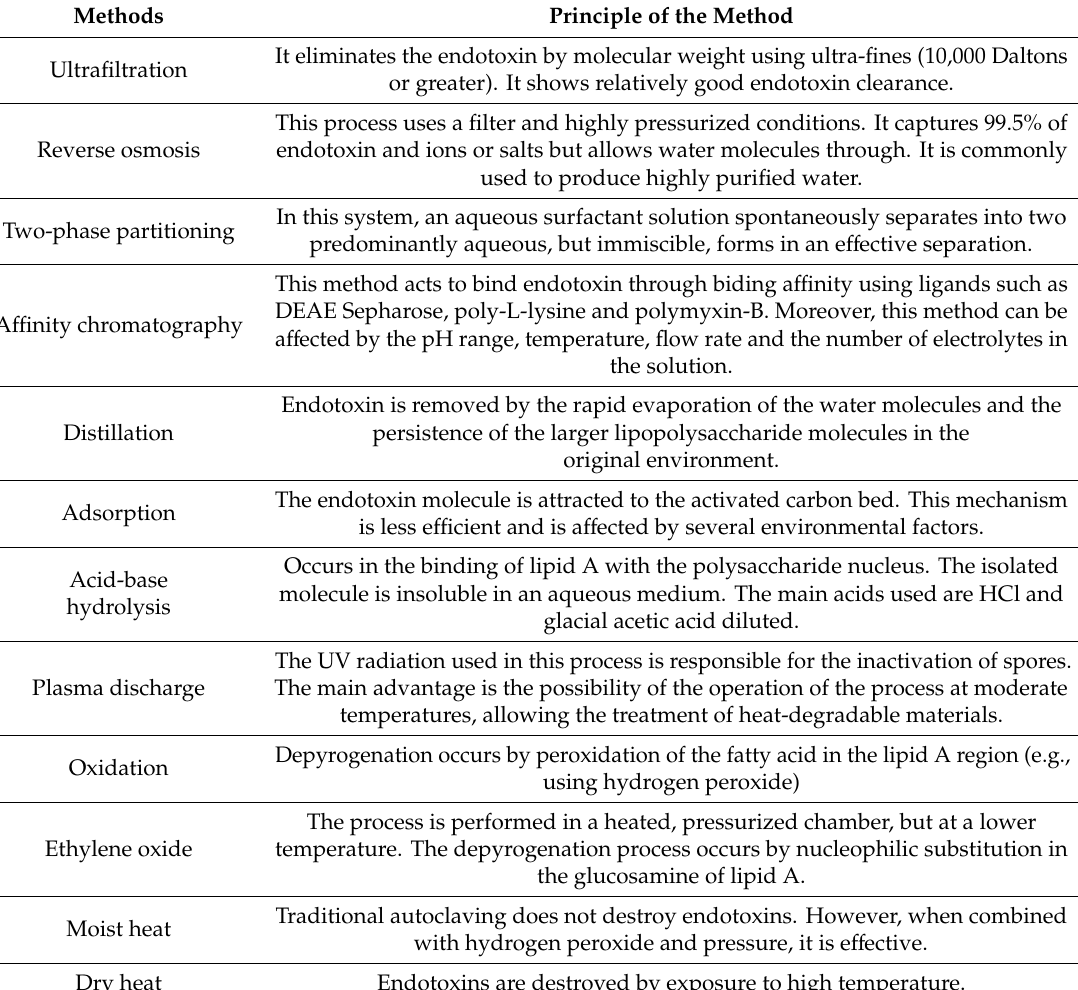
Table 2. Methods used to remove endotoxin